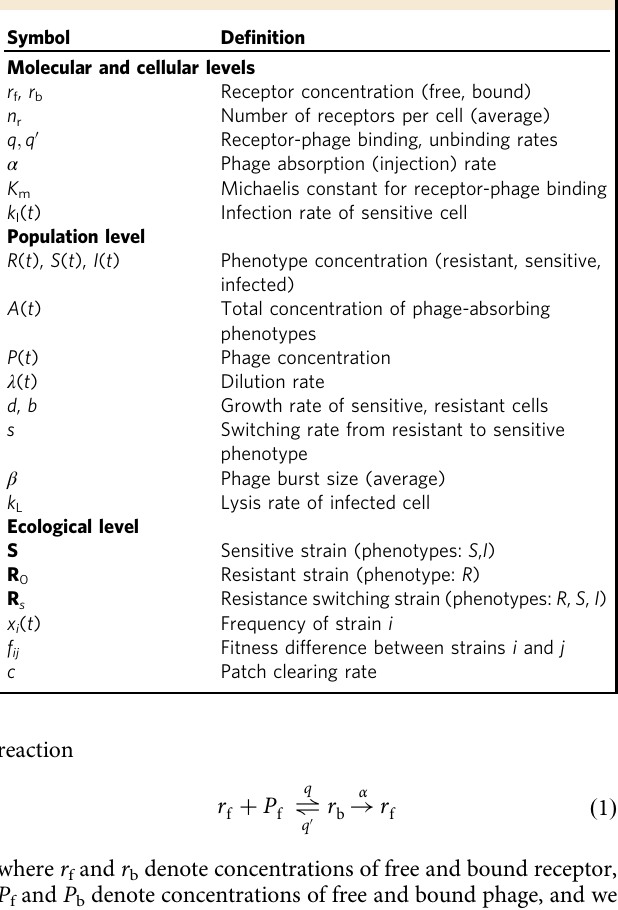
Table 1 Notation Guide. Key symbols and their meaning for each stage of the multi-level